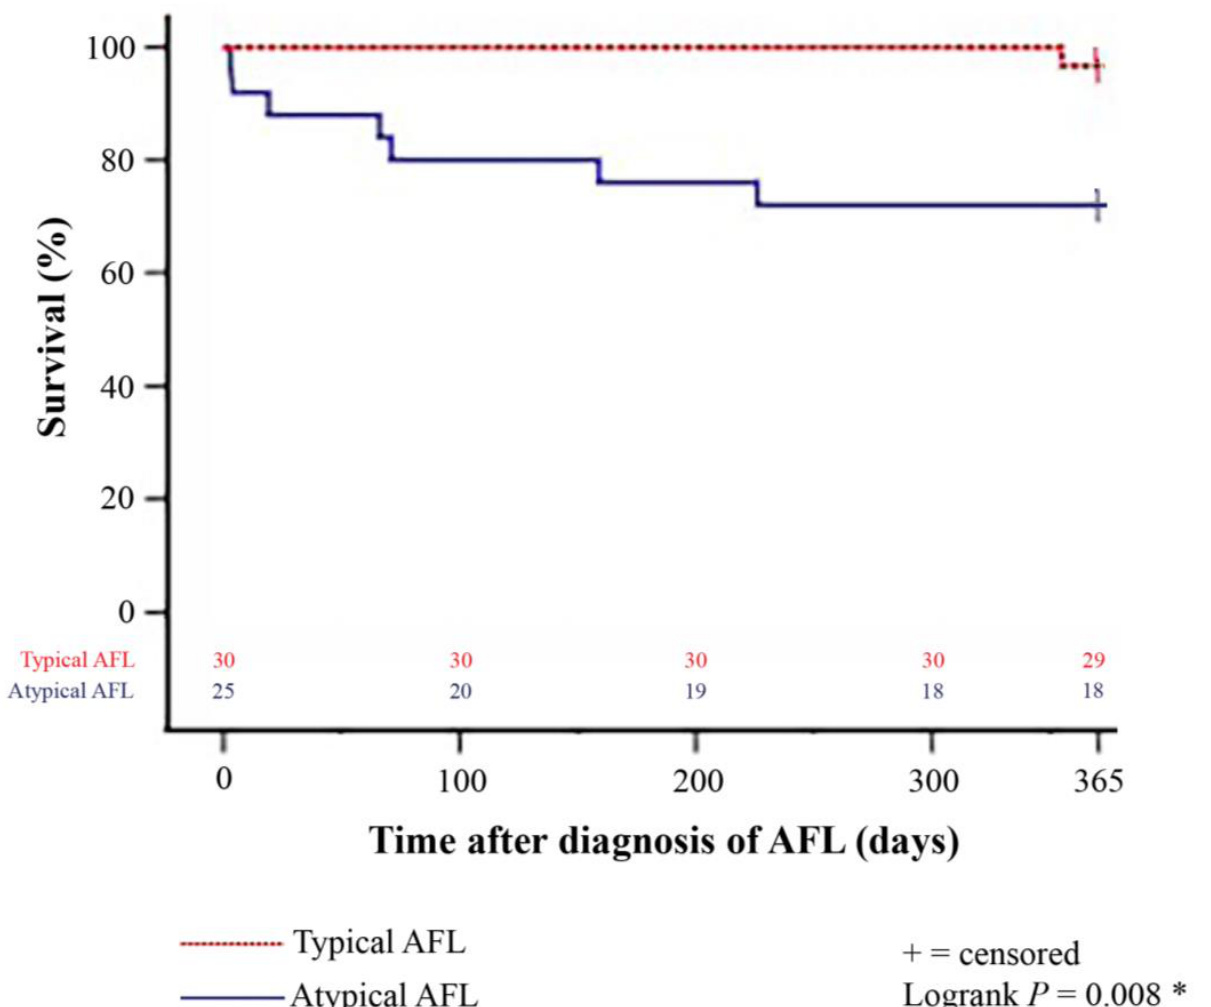
Figure 2. One-year survival after diagnosis of late-onset post-transplant AFL in patients with typical and atypical AFL (Kaplan–Meier estimator). Patients with atypical late-onset post-transplant AFL showed a statistically significant inferior 1-year post-transplant survival (18 of 25 [72.0%]) in comparison to patients with typical late-onset post-transplant AFL (29 of 30 [96.7%]; p = 0.008). AFL = atrial flutter; * = statistically significant ( p < 0.050). Stratified by causes of death, patients with atypical AFL also had a significantly higher rate of graft failure within one year after diagnosis of late-onset post-transplant AFL (4 of 25 [16.0%] versus 0 of 30 [0.0%]; p = 0.023). Mortality and causes of death within one year after diagnosis of late-onset AFL after HTX are presented in Table